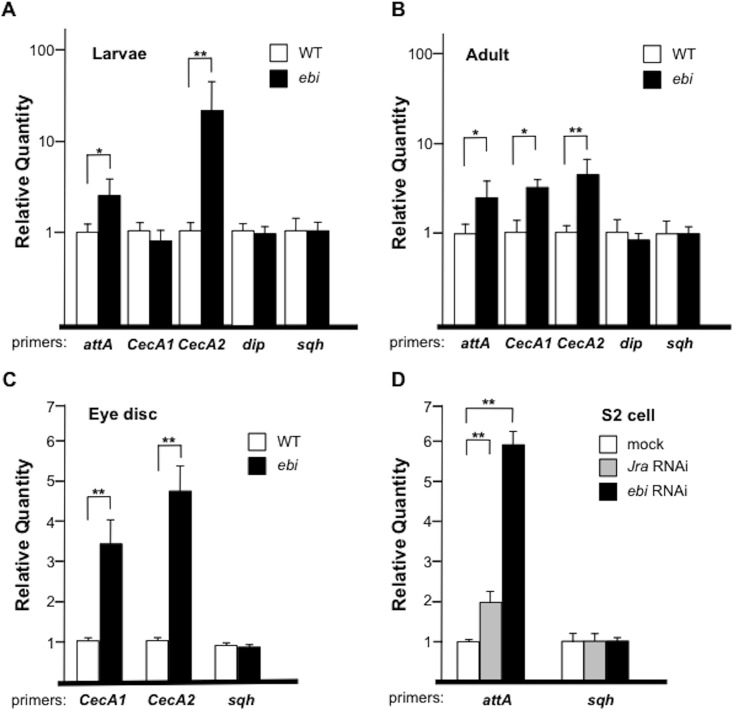
Ebi and AP-1 antagonize IMD signaling.(A–D) qPCR analysis of mRNA from wild-type (WT) or ebi mutant (ebi
P
/ebi
4) first-instar larvae (n = 36 and 25, respectively) (A), from WT or ebi mutant escaper (ebi
7
/ebi
90) adult flies (n = 30 and 21, respectively) 1 day after eclosion (B), from WT or ebi mutant escaper (ebi
11
/ebi
4) third-instar larvae eye-antennal discs (n = 80 and 65, respectively) (C), and from S2 cells treated with mock dsRNA, dsRNA against Jra (RNAi), or ebi RNAi (D). attA: attacinA; sqh: spaghetti squash. Data represent the mean ± SD. *p < 0.05; **p < 0.01. (A) and (B) were platted by a log scale.